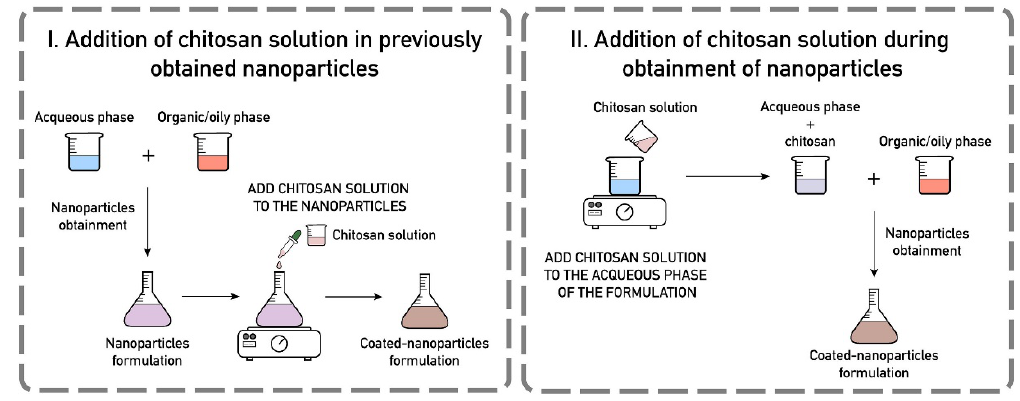
Figure 9. Different approaches of chitosan coatings for nanoparticles. (Reprinted with permission from [90] Copyright (2020), Elsevier).